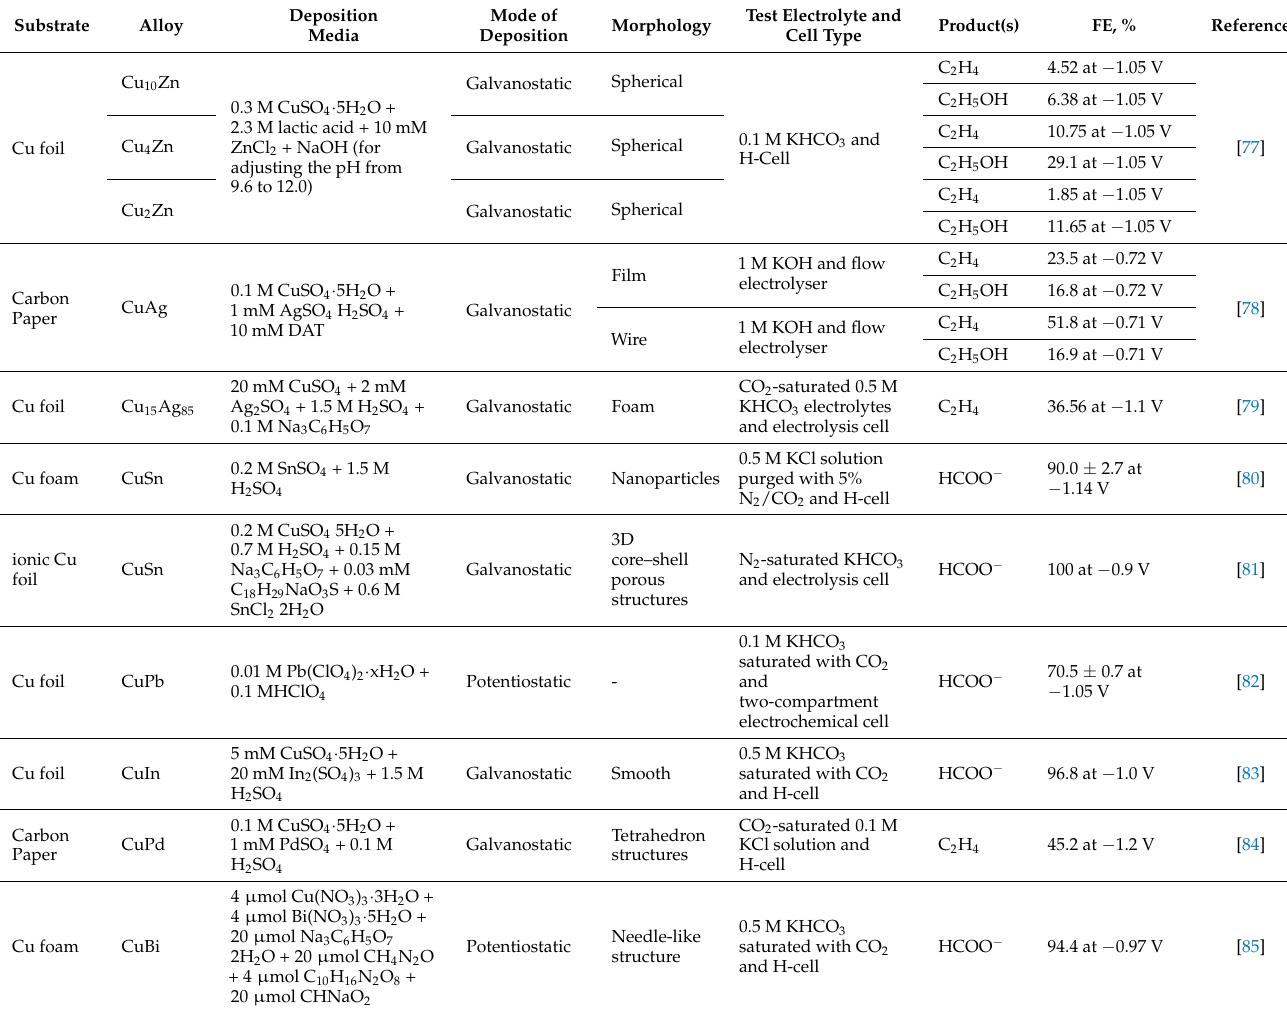
Table 5. Works that reported on the electrodeposition of copper